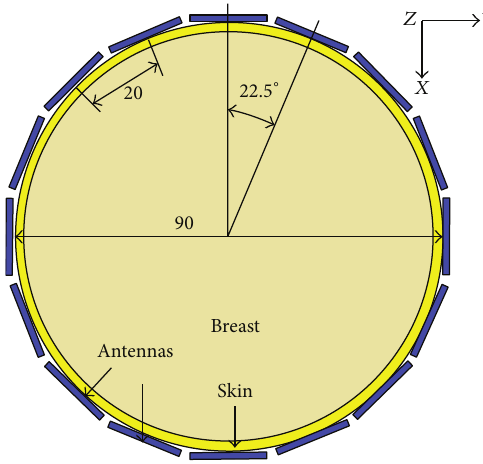
Figure 2: Circular antenna array for full view geometry.